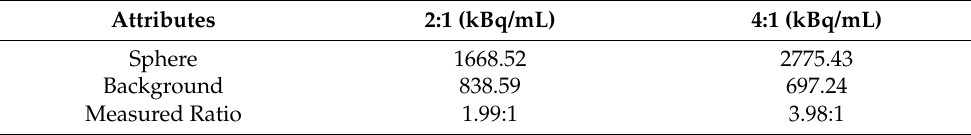
Table 1. Activity concentration of the spheres and background for different